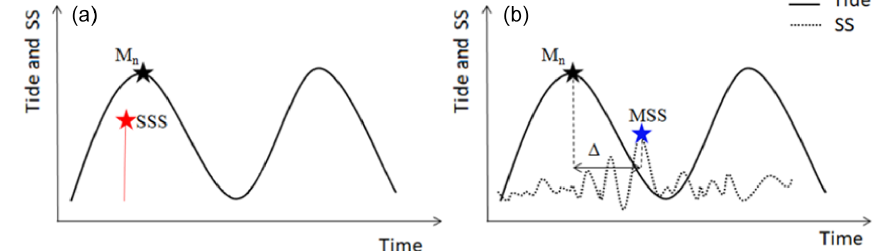
Figure 2. Illustration of tide and storm surge signals for the of joint surge–tide probability procedures: (a) skew surge–tide combination; (b) maximum surge–tide combination.